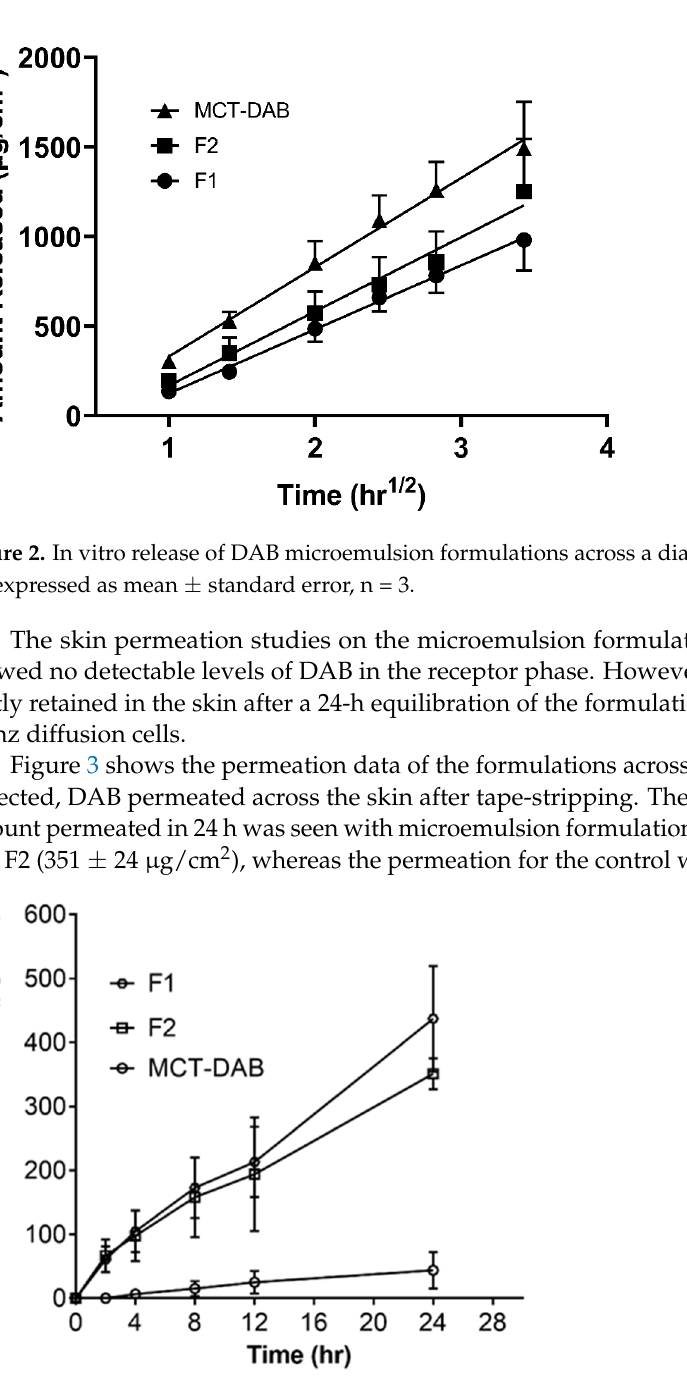
Figure 3. Skin permeation and flux of DAB from microemulsions after tape-stripping of human cadaver skin. All data are expressed as mean ± standard error, n = 3.